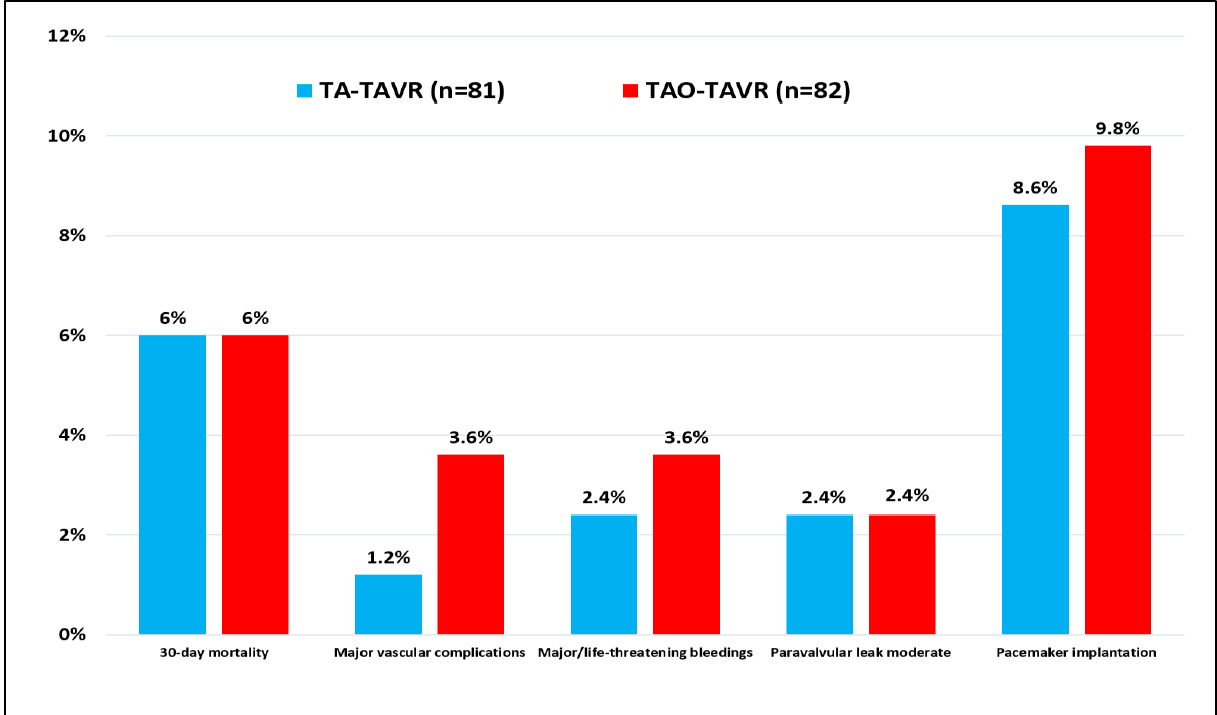
Figure 1. Postoperative complications after TA-TAVR and TAO-TAVR procedures according to VARC-3 definitions.